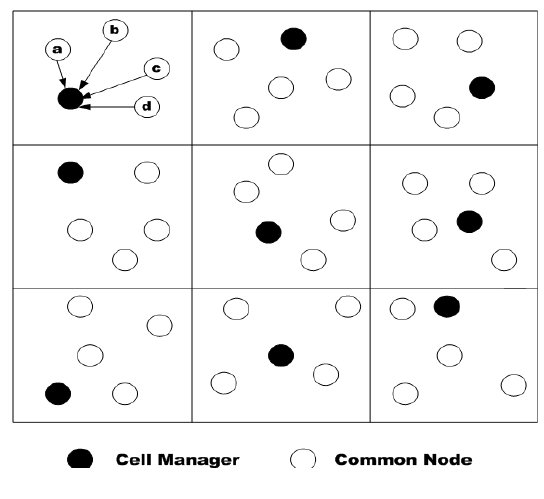
Figure 10. Virtual grid of